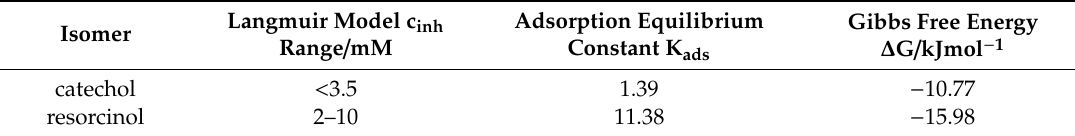
Table 3. The applicability range of the Langmuir adsorption model and the obtained thermodynamic parameters for resorcinol and